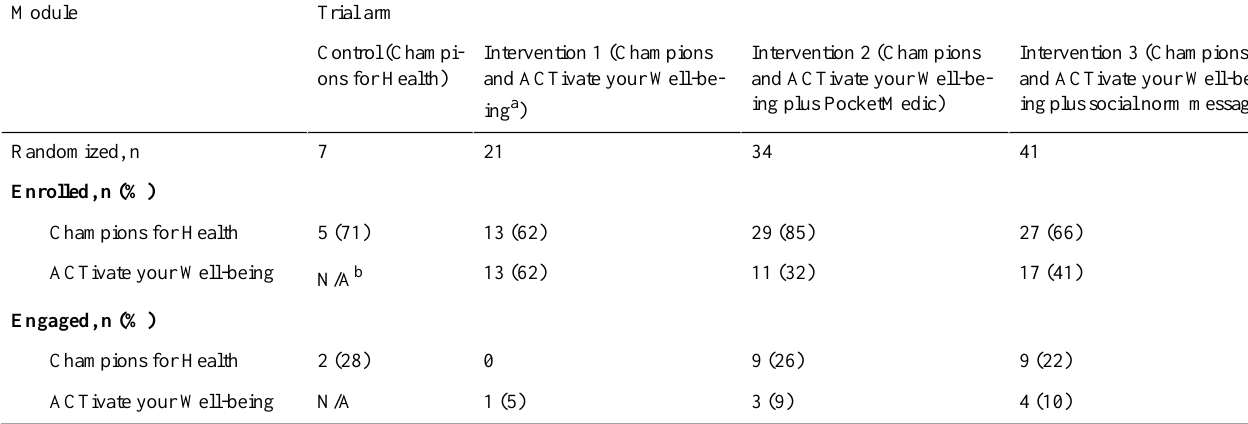
Table 2. Module engagement (no. of participants) per trial arm (n=103).